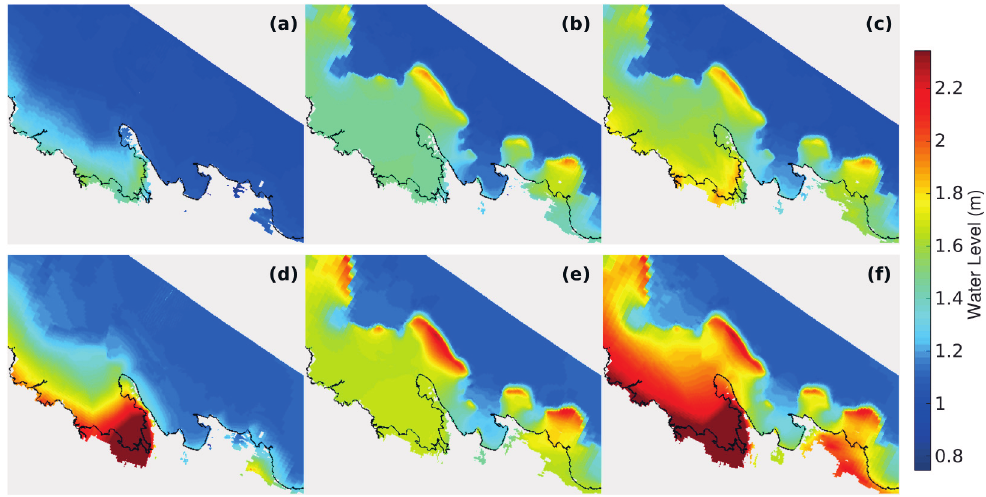
Figure 6. Water level maxima for the 100-year RI ensemble, “baseline” scenario.